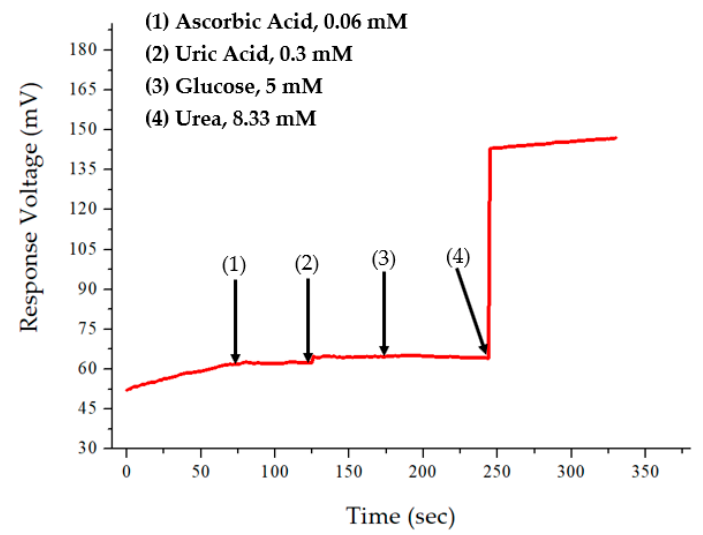
Figure 8. The result of the interference effect for flexible arrayed RuO 2 urea biosensor.